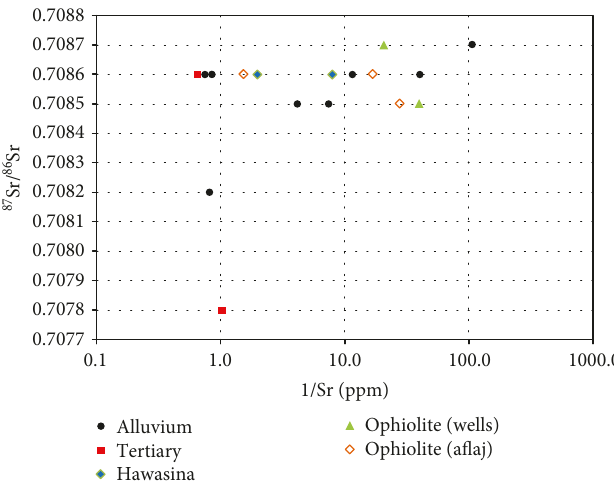
Figure 8: 87 Sr/ 86 Sr ratio vs. 1/Sr for groundwater from ophiolite, Tertiary, and alluvium aquifers.